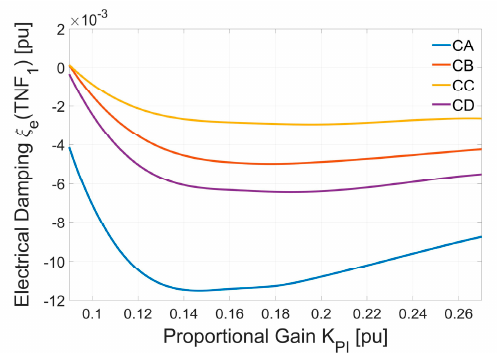
Energies 2020 , 13 , x FOR PEER REVIEW